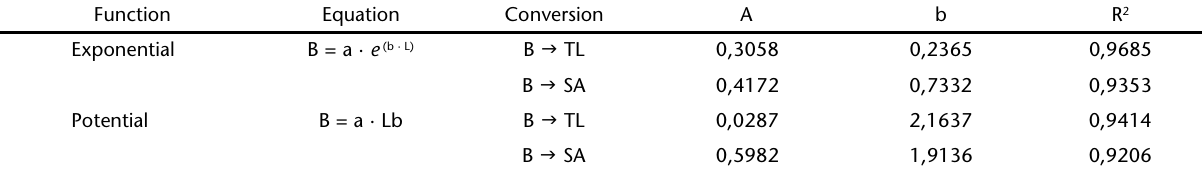
Table I. Regression equations and values found for each variable. The biomass is represented by B, and the shell total length (TL) and shell aperture (SA) of M. tuberculatus are represented by L. (a and b) regression constants, (R²) coefficient of determination, (e) Euler's number